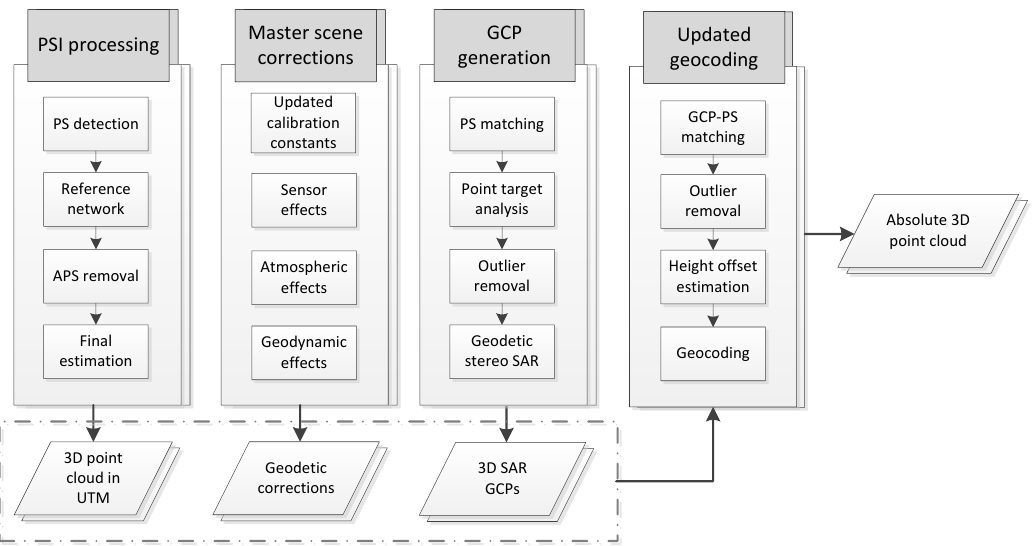
Figure 4. Workflow of the utilized geocoding error correction method. The processing steps, included in the big rectangles, are carried out independently and their results are shown by the parallelograms. The double shapes indicate that each processing is carried out for two or more SAR image stacks, which is the necessary condition for GCP